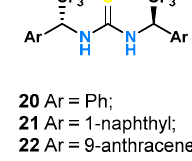
Figure 8. Simple symmetric thiourea receptors 17 – 22 .